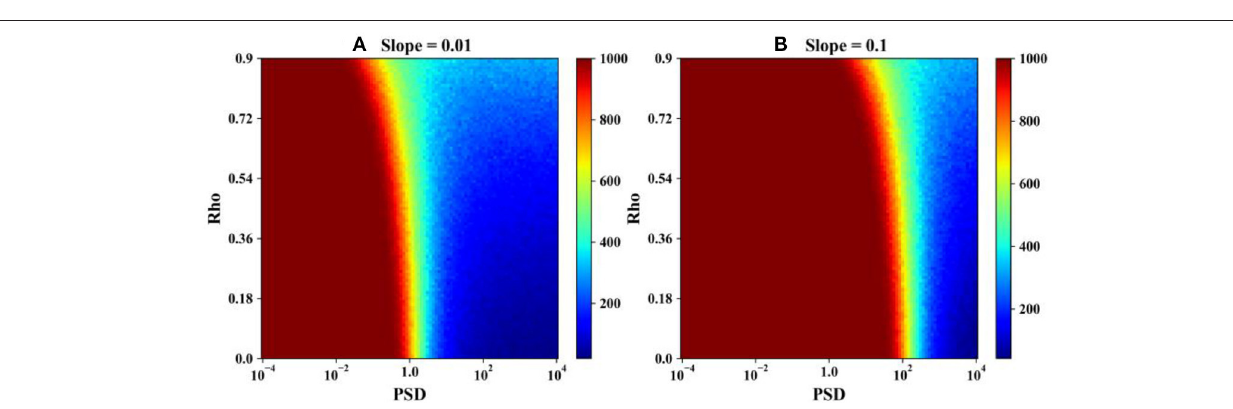
FIGURE 12 | Heat maps of the rejection rate with different combinations of PSD values and serial correlation values, where the sample length is 100 and the slope values are equal to 0.01 and 0.1, respectively. (A) Slope value